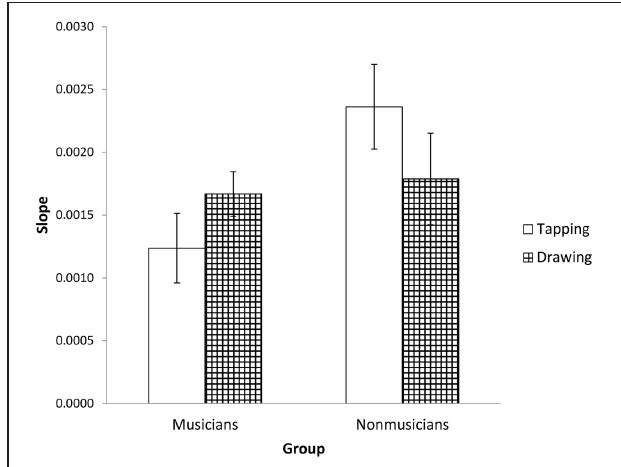
FIGURE 3 | Average slopes of the lines formed from plotting Unpaced IRI variance against the square of the prescribed interval duration. Standard error bars are shown.